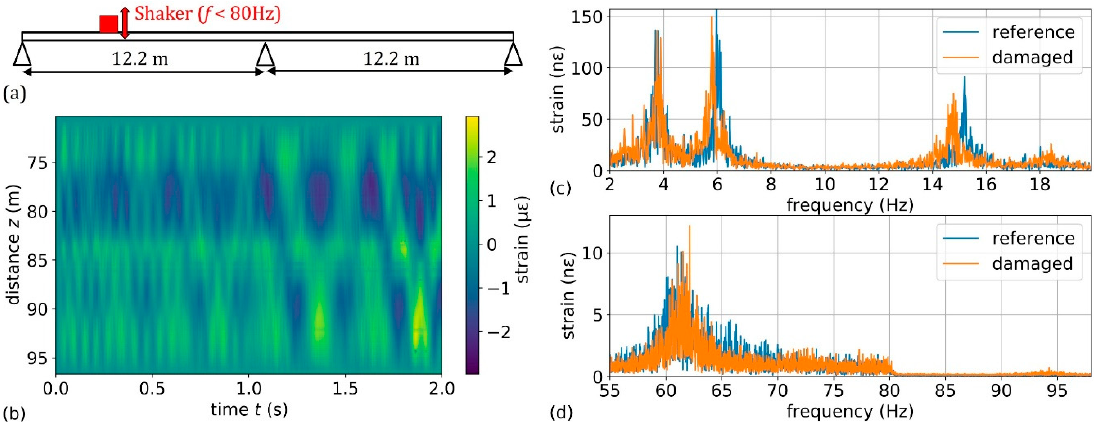
Figure 2. ( a ) Schematic of the model bridge. ( b ) Measured strain distribution during white noise excitation. ( c , d ) show the mean strain amplitude spectrum over the entire length of the structure before and after damage. ( f s = 1 kHz, f p = 200 kHz, 1 m spatial resolution, 20.4 cm sampling